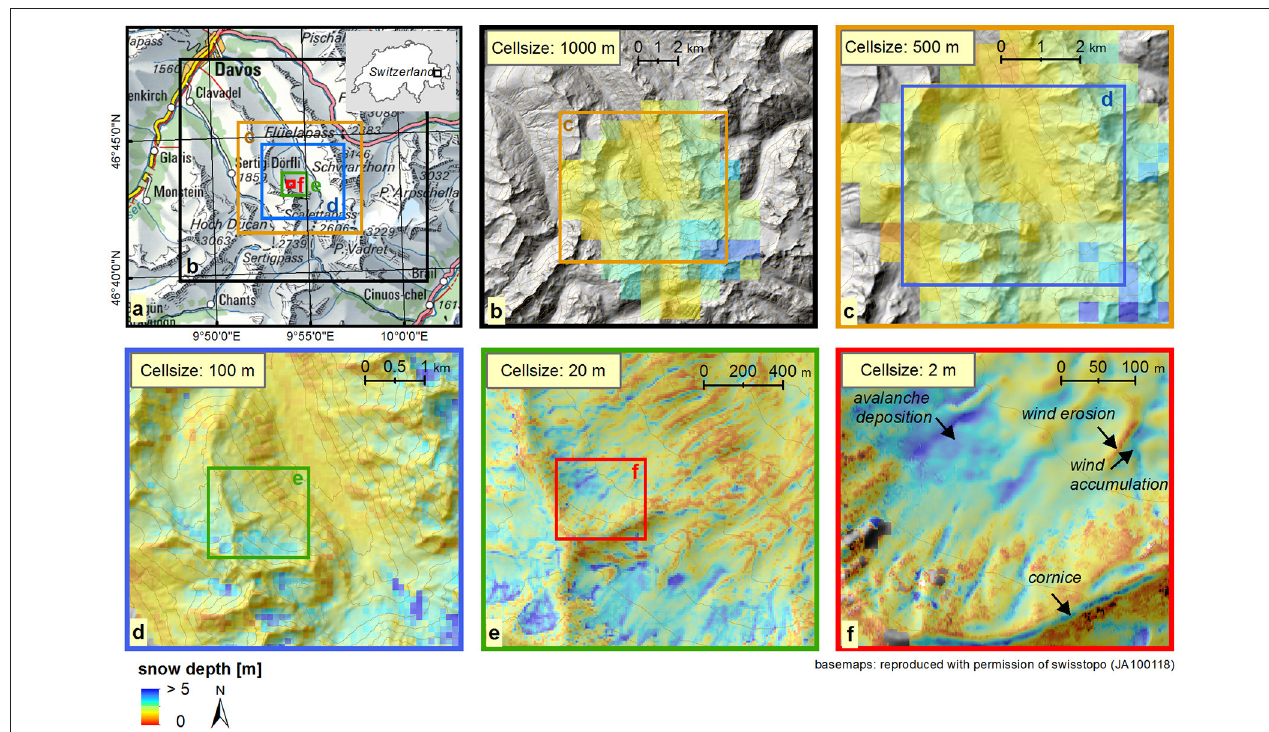
FIGURE 1 | Snow depth variability represented by different measurement resolutions: 1,000m (b) , 500m (c) , 100m (d) , 20m (e) , and 2m (f) . An overview of the different domains is provided in (a) . Same data set as used in Grünewald et al. (2014).